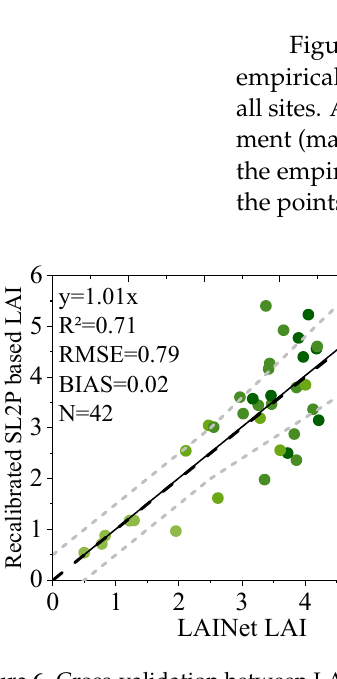
Figure 6. Cross-validation between LAINet LAI and ( a ) the recalibrated SL2P-based LAI, ( b ) the empirically based LAI for the green-up season (from day of year (DOY) 152 to 211). The black dashed line indicates the 1:1 line, the solid line indicates the linear regression, and the gray dashed lines show the Global Climate Observing System uncertainty requirements for LAI (max (0.5, 20%)).